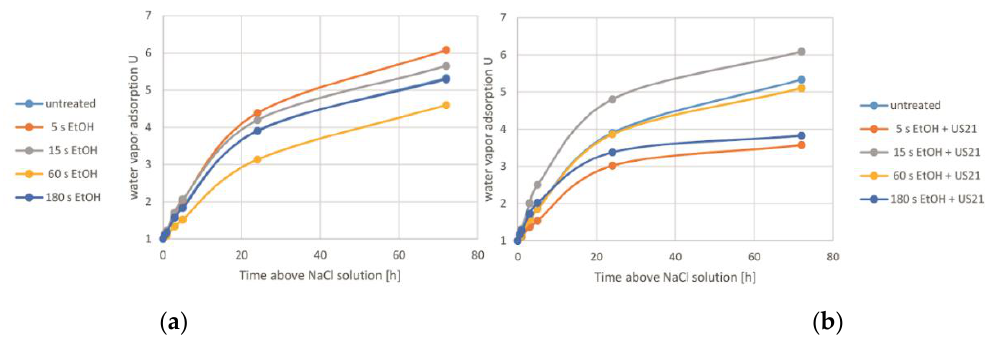
Figure 4. Kinetics of the water vapour adsorption (hygroscopic properties) of dried carrot tissue pre-treated in ethanol without ( a ) and with ultrasound ( b ).